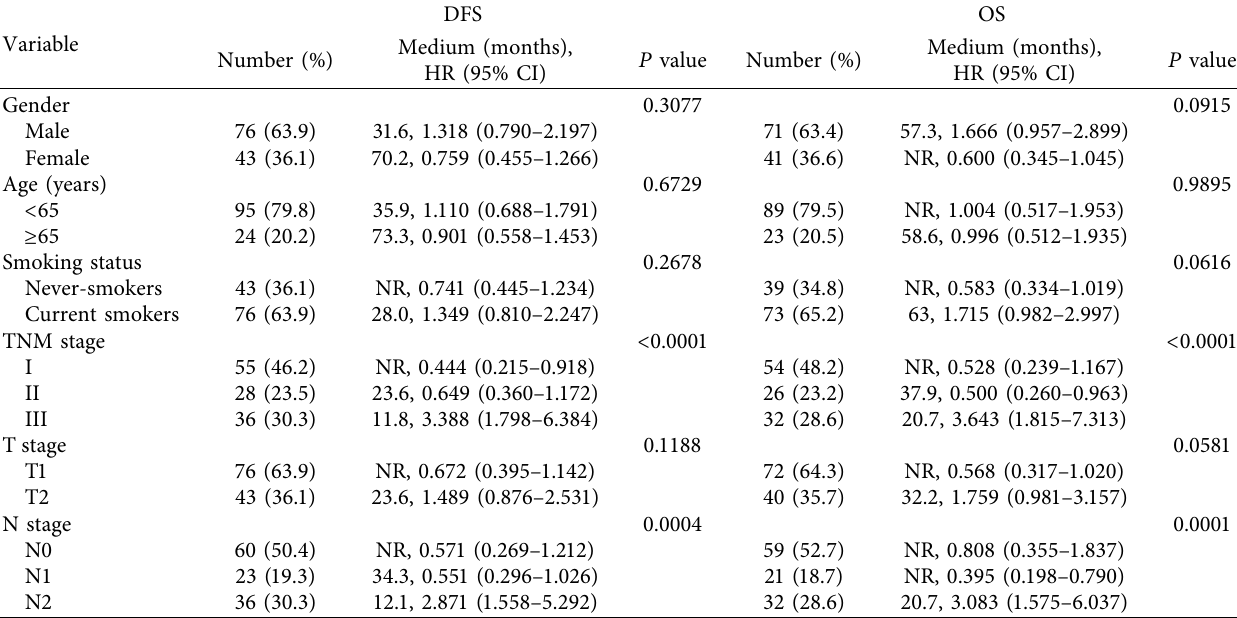
Table 2: Patient distribution and characteristics associated with DFS and OS.